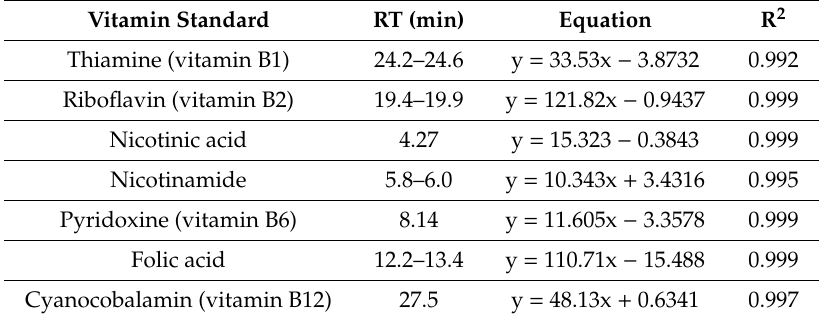
Table 1. Retention time (RT) and equation of the calibration lines for each vitamin standard together with the respective R 2 values.